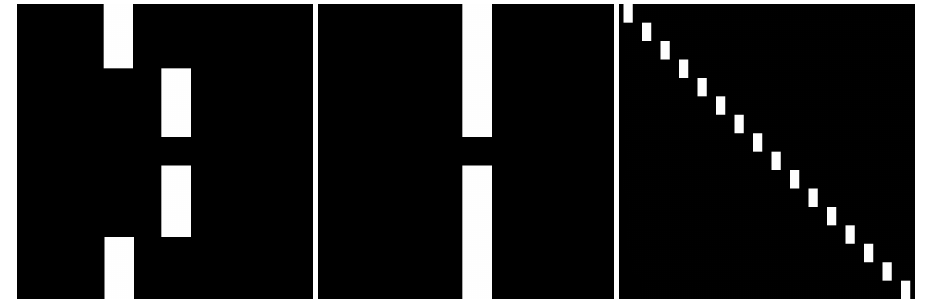
Figure 4. Artificial membrane structures with obstacles in different positions. These three structures are designed to show which distributions of obstacles can cause changes in transport. Left panel: The first structure has three breaks (structure S1). Central panel: The second structure has only one break, at the central point of the membrane (structure S2). Right panel: The third structure has obstacles aligned along the main diagonal of the structure (structure S3). The breaks between the obstacles are equally